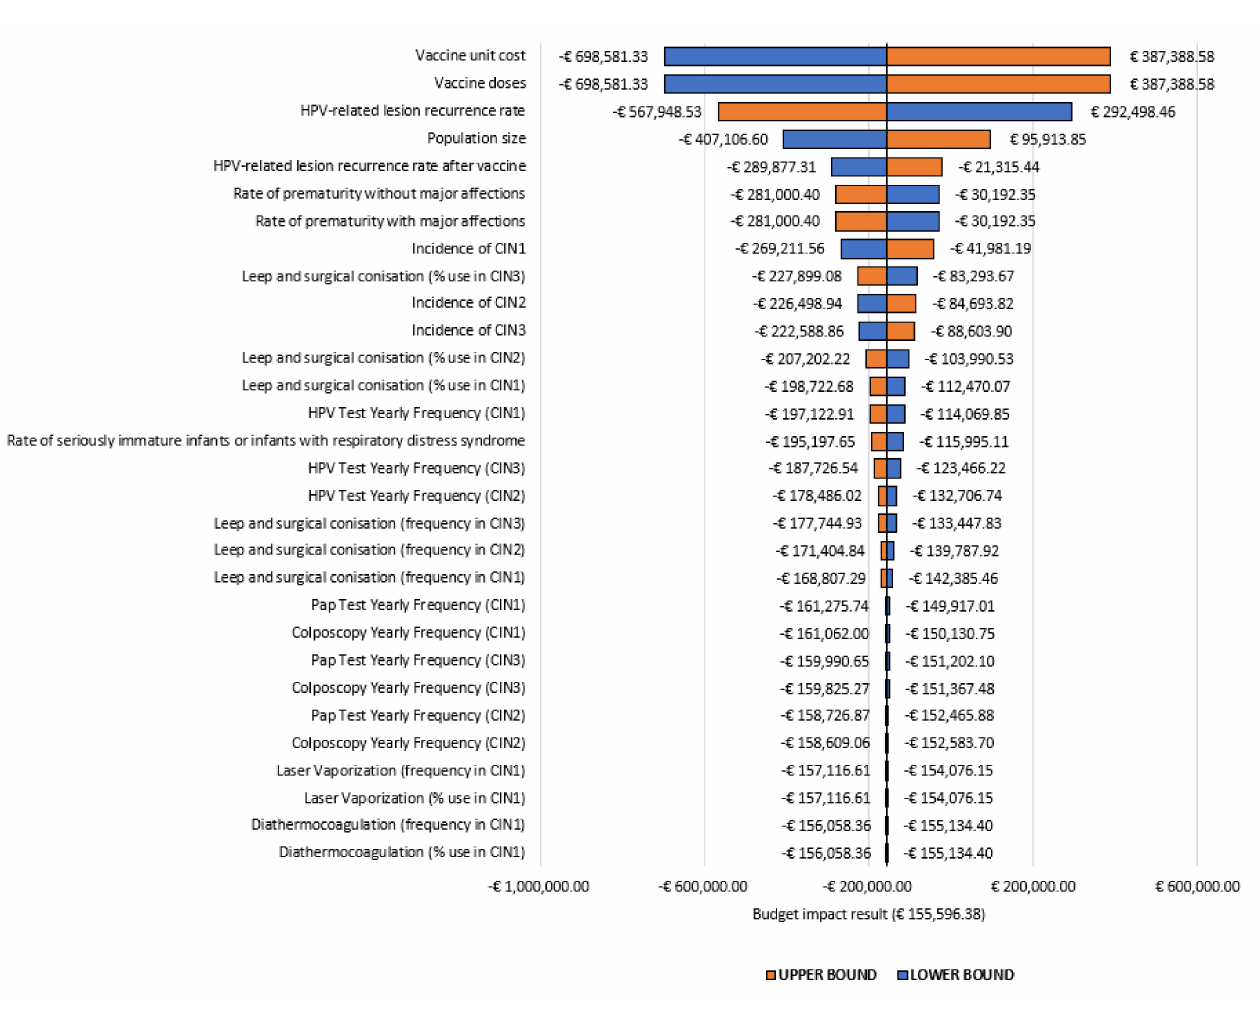
Figure 1. Deterministic